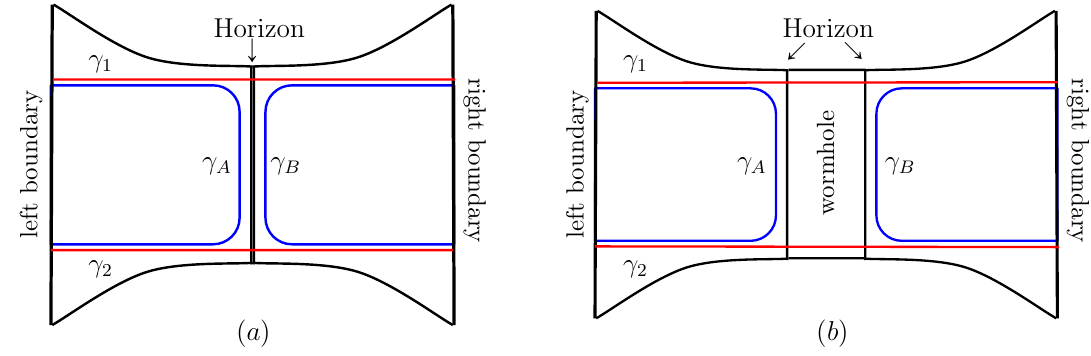
Figure 4 . (a) Schematic representation of the t = 0 slice of the two-sided black brane geometry. (b) Schematic representation of the shock wave geometry, in which the wormhole becomes longer. In both cases the blue curves represent the U-shaped extremal surfaces (cid:13) A (in the left side of the geometry) and (cid:13) B (in the right side of the geometry). The red curves represent the extremal surfaces (cid:13) 1 and (cid:13) 2 connecting the two sides of the geometry. The extremal surface (cid:13) wormhole de(cid:12)ned in